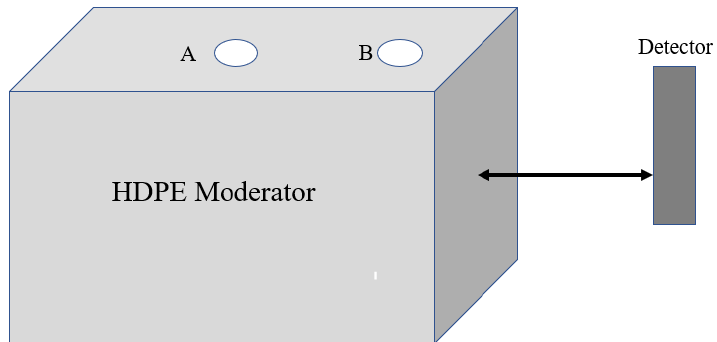
Figure 5. Experimental setup schematic for neutron absorption measurement [18,79].